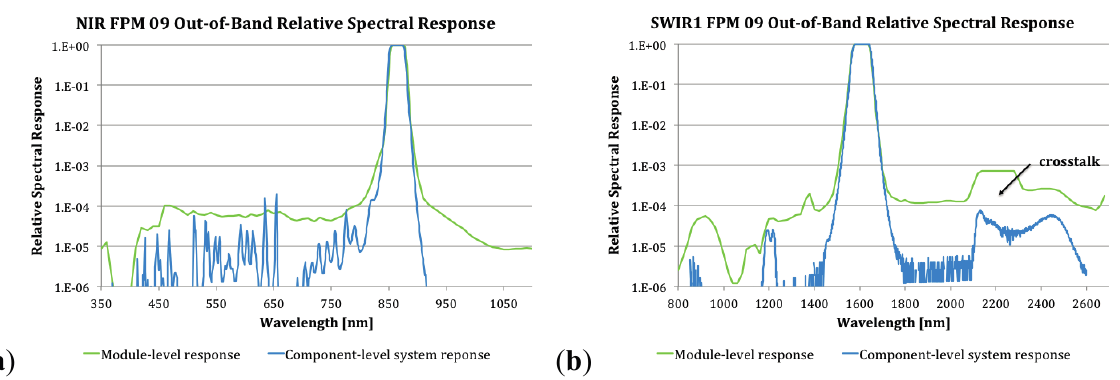
Figure 7. FPM-average out-of-band response for FPM9 of ( a ) NIR and ( b ) SWIR1 bands. In general, the component-level measurements indicate less out-of-band response than the module test and it is difficult to know how much of this difference is attributable to the test setup and not OLI. However, in the SWIR bands there is a cross-talk feature that on-orbit analyses show is real. The increase in out-of-band response centered at 2200 nm corresponds to the SWIR2 band, indicating the presence of spectral